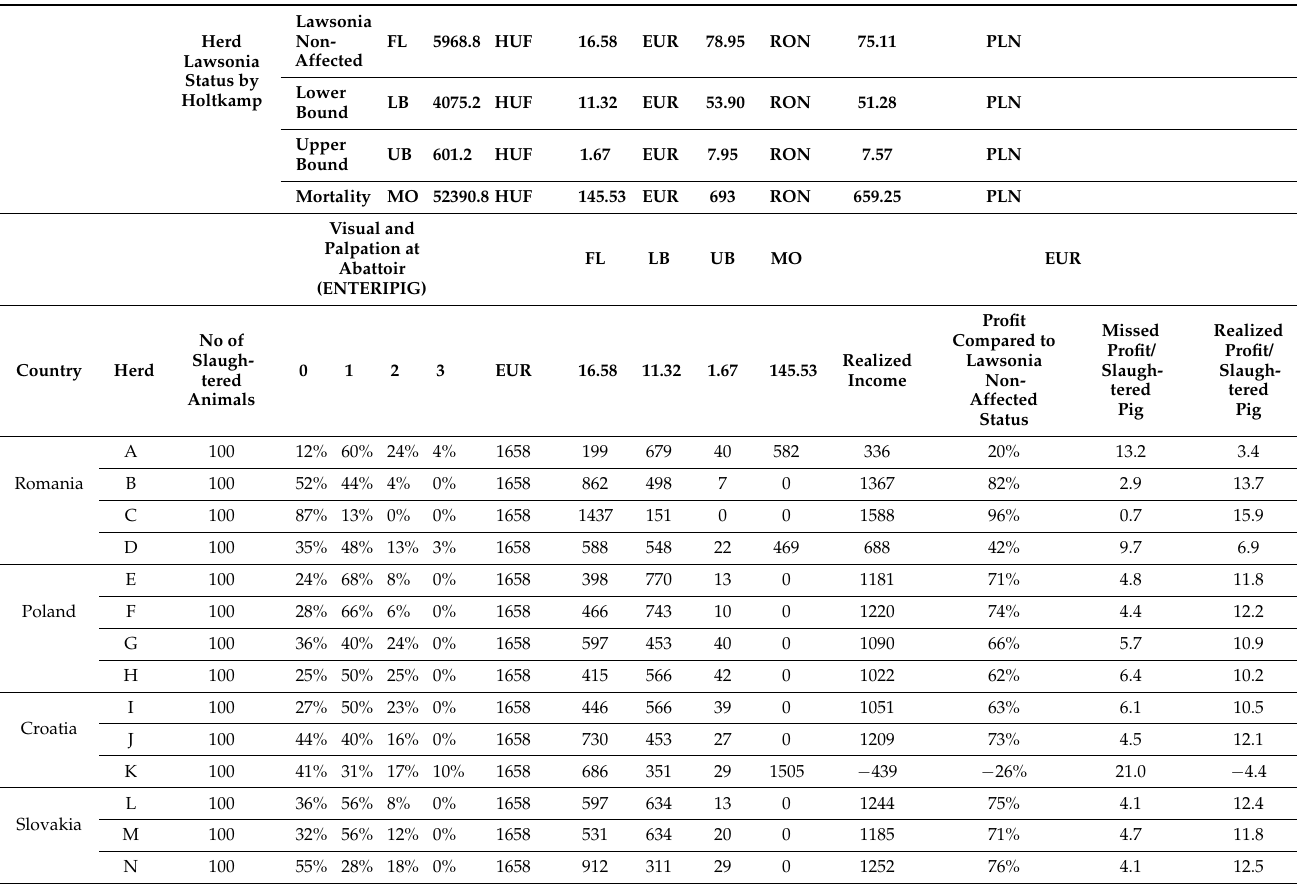
Table 10. Economic losses in RO, PL, CR,